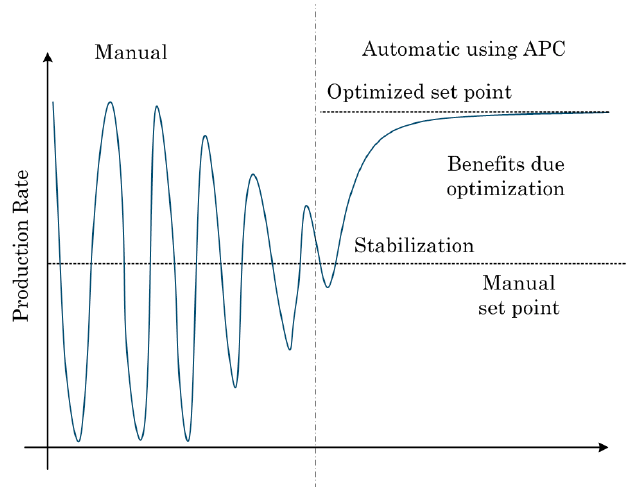
Figure 1. The benefits of the MPC enabling optimization.